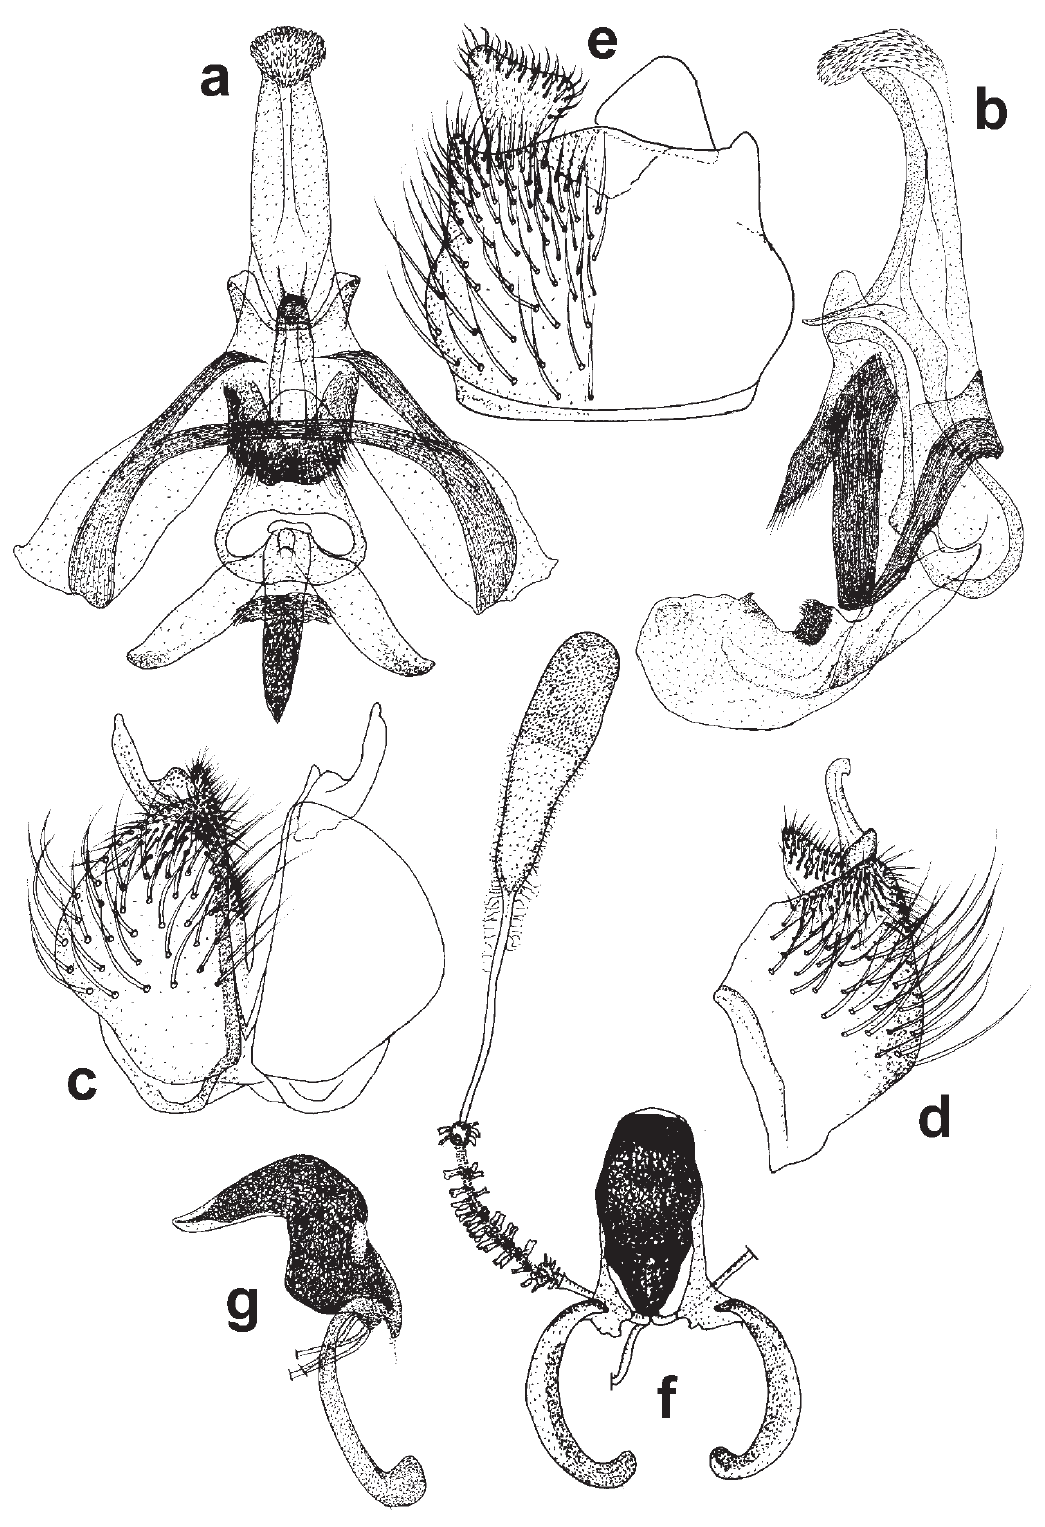
Fig. 42. Protypusia separata Gibbs & Theodor gen. et sp. nov. a . Epiphallic complex ventral. b . Epiphallic complex lateral. c . Gonocoxite ventral. d . Gonocoxite lateral. e . Epandrium dorsal. f . Female genitalia ventral. g . Female genitalia